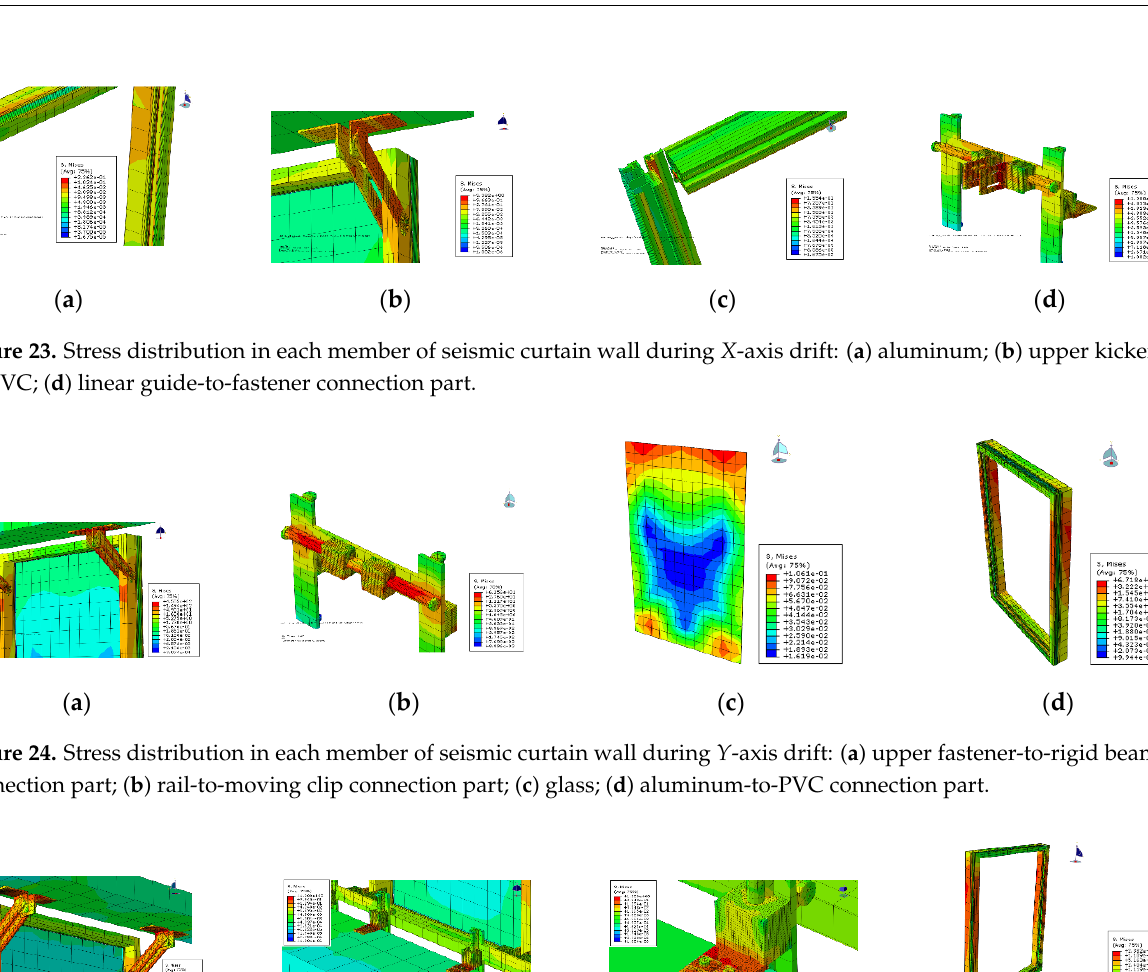
Figure 22. Stress distribution in each member of non-seismic curtain wall during Z -axis drift: ( a ) glass; ( b ) aluminum; ( c ) PVC; ( d ) aluminum-to-fastener.